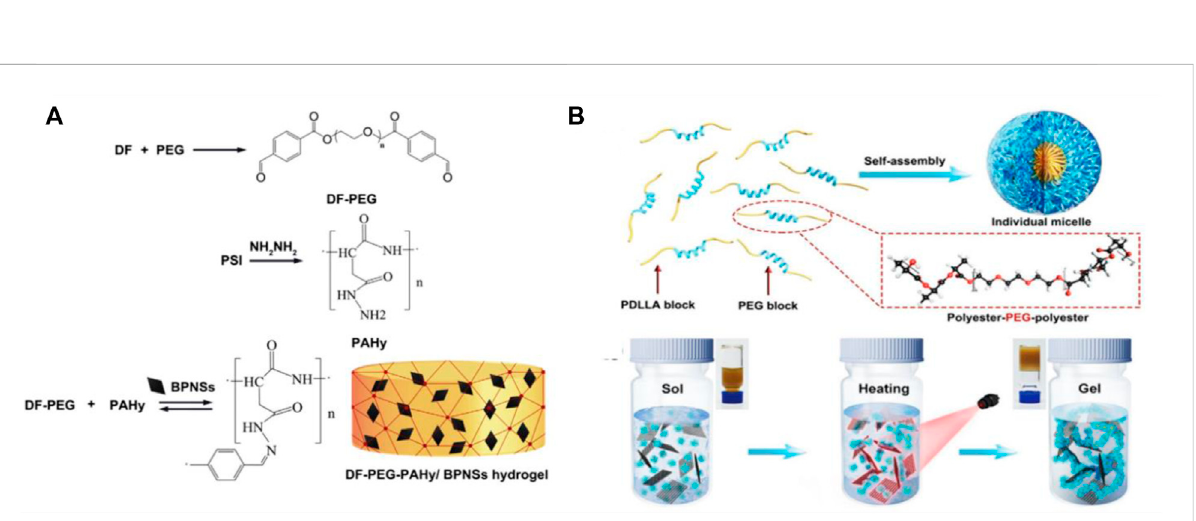
FIGURE 4 (A) Schematic diagram of preparation of black photothermal nanohybrid hydrogels. Reproduced from ref. 82 with permission from 2019PublishedbyElsevierInc. (B) Preparationofblackphosphorusnanohydrogel anditsschematicdiagramofgelsoltransitionunderinfraredlight irradiation. Reproduced from ref. 70 with permission from 2018 The Authors. Published by